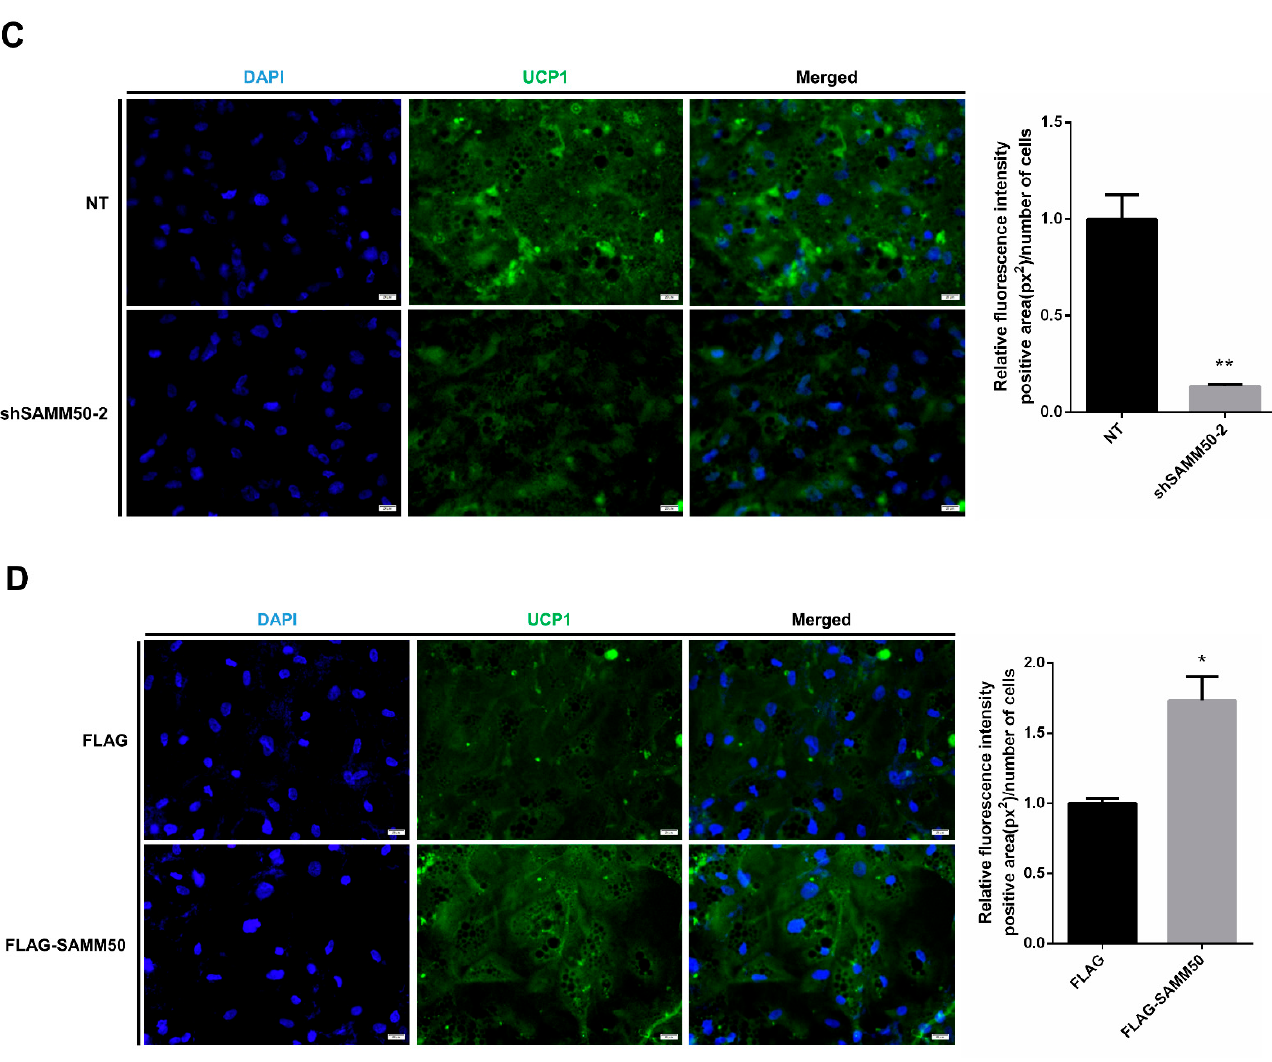
Figure 5. Effects of SAMM50 knockdown or overexpression on the expression of UCP1 in beige adipocytes. ( A , B ) The expression levels of UCP1 in beige adipocytes infected with shSAMM50 ( A ) and FLAG-tagged SAMM50 ( B ) were analyzed using qPCR. ( C , D ) Representative fluorescence images of beige adipocytes infected with shSAMM50 ( C ) and FLAG-tagged SAMM50 ( D ) were stained with DAPI (blue) and anti-UCP1 (green), respectively. The fluorescence levels of UCP1 were quantified using ImageJ software. Results are shown as mean ± SEM. * p < 0.05; ** p < 0.01; *** p < 0.005 compared to the controls.